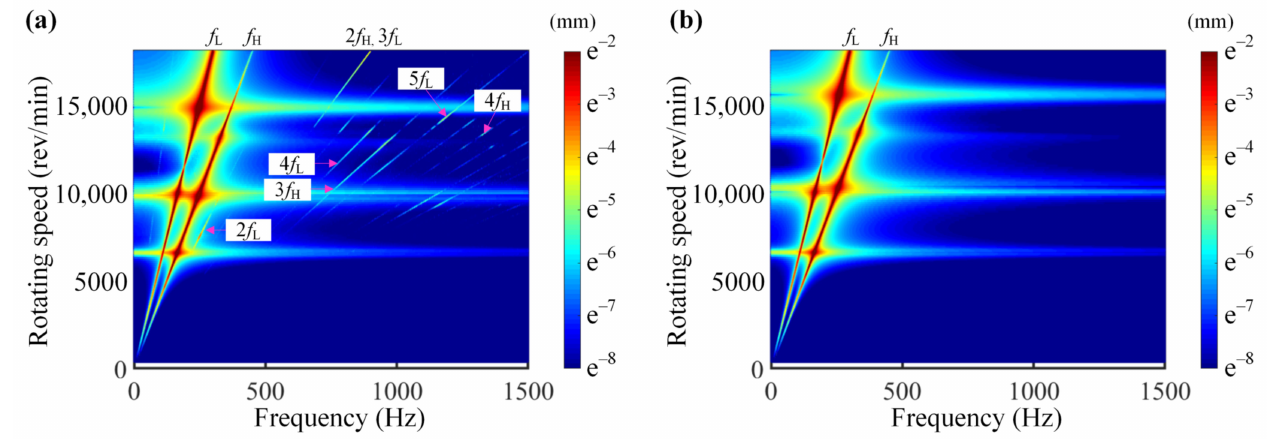
Figure 8. Spectrum cascades: ( a ) model with bolted joints; ( b ) model without bolted joints.